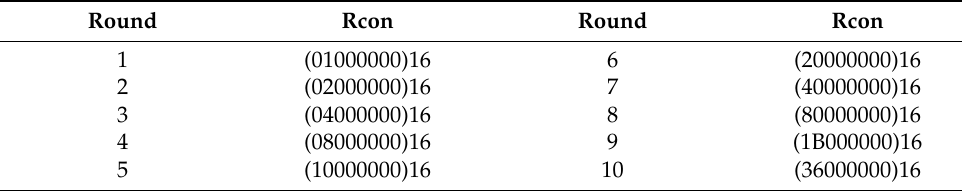
Figure 1. Typical key expansion architecture. Table 2. R constant values for different rounds in AES–128.